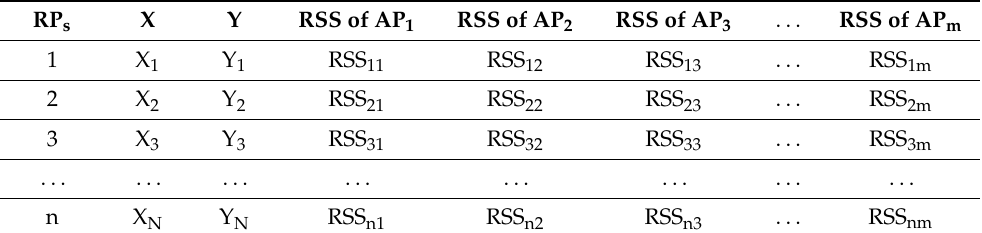
Table 1. Fingerprint database format.